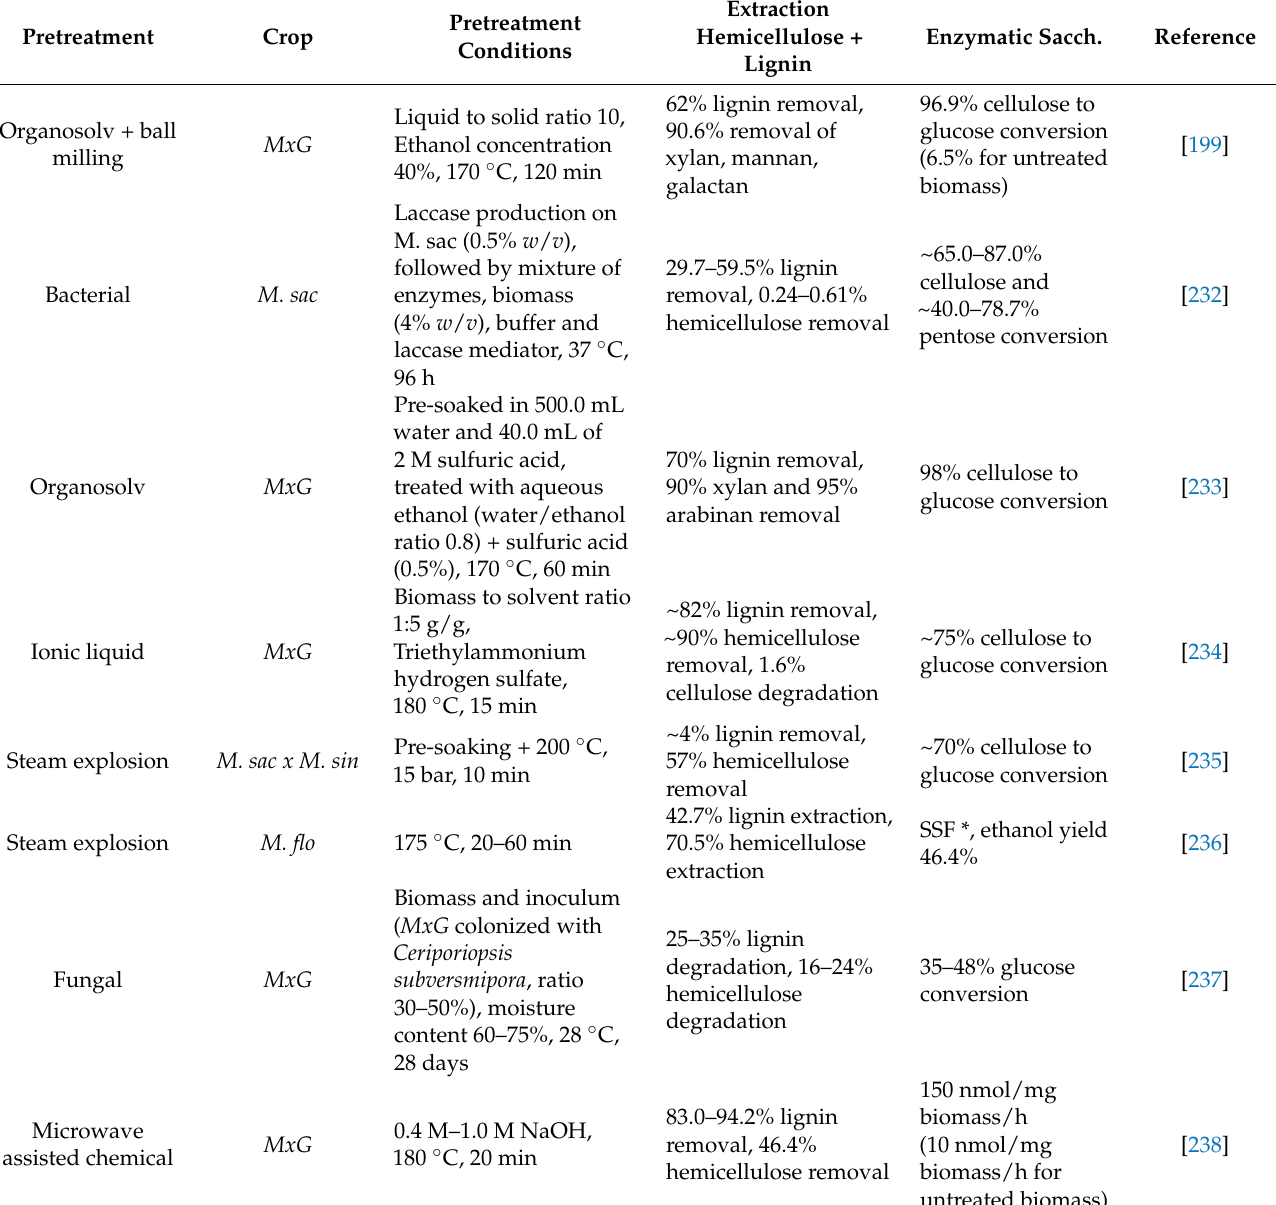
Table 1. Different types of pretreatments that have been applied on miscanthus biomass and their effect on biomass composition and enzymatic saccharification. * Simultaneous saccharification and